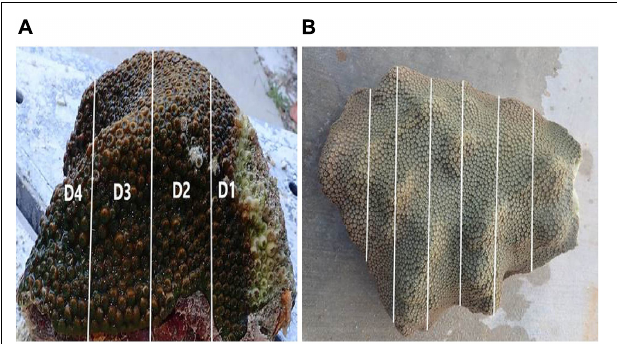
FIGURE 1 | (A) Gross appearance of an SCTLD-affected diseased donor, Montastraea cavernosa , colony with a subacute lesion used for the induction studies. Representation of the longitudinal fragmentation of a donor colony cut into sequential “distances” ∼ 8 cm apart (Distance 1–Distance 4; D1–D4) from the lesion margin. (B) Representation of the longitudinal fragmentation of a recipient colony cut into fragments ∼ 10 cm long × 3 cm wide × 2 cm high.